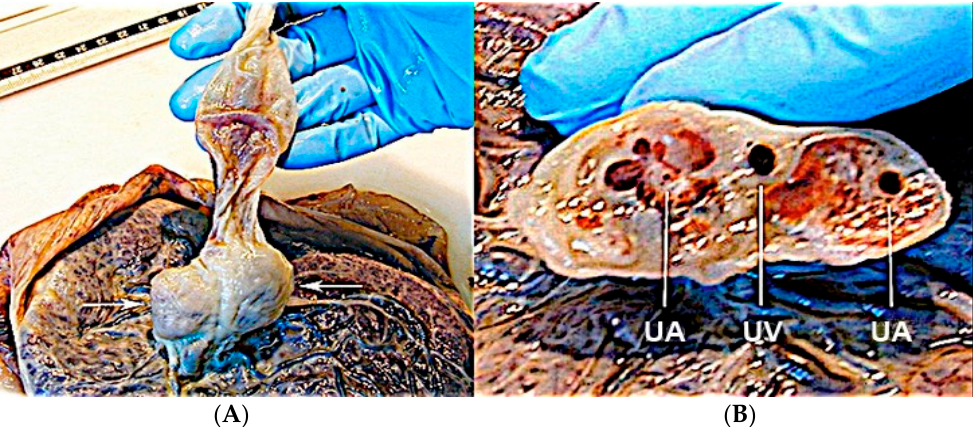
Figure 27. Pathologic correlation. Umbilical cord hemangioma at the fetal face of the placenta ( A ) and the axial section of the umbilical cord ( B ) showing a large hematoma in one of the two umbilical artery (UA: umbilical artery; UV: umbilical vein). Evident increase in the diameter of the cord due to swelling and myxoid-edematous degeneration. The section of the cord shows the two umbilical arteries surrounded by thick angiomatous tissue.